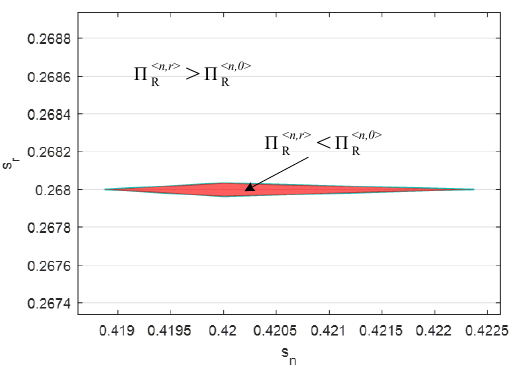
Figure 11. The profits of the remanufacturer in < n , 0 > and < n , r > scenarios.